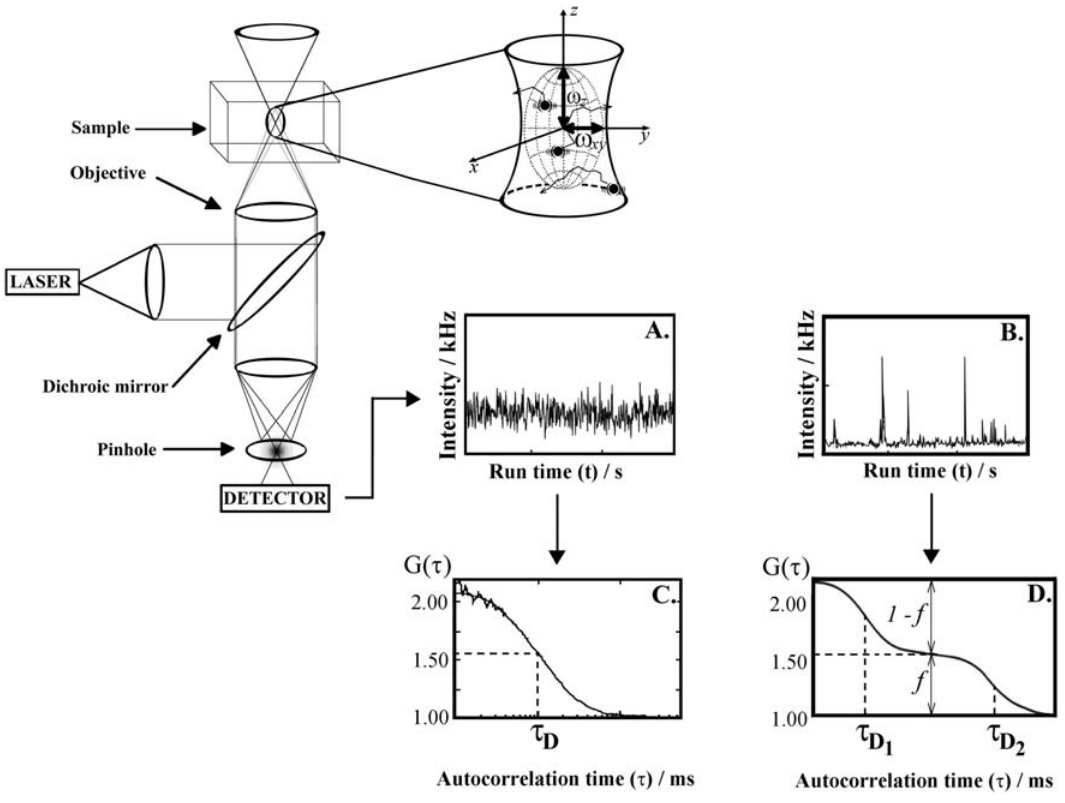
Figure 6. Schematic presentation of the instrumentation for FCS/CLSM. To induce fluorescence, the sample is illuminated by incident laser light. The irradiating laser beam is reflected by a dichroic mirror and sharply focused by the objective to form a diffraction limited volume element. A confocal aperture, set in the image plane to reject the out-of-focus light, further reduces the volume from which fluorescence is detected. This is crucial for providing an elliptical observation volume element and enabling submicrometer resolution and quantitative analysis. Following the absorption of energy, fluorescent molecules lose energy through photon emission. Light emitted by fluorescing molecules passing through the confocal volume element (magnified in the insert) is separated from the exciting radiation and the scattered light by a dichroic mirror and barrier filter, and transmitted to the detector. The number of pulses originating from the detected photons, recorded during a specific time interval, corresponds to the measured light intensity. Examples of fluorescence intensity fluctuations recorded in systems with one component undergoing A. free three-dimensional diffusion or B. free three-dimensional diffusion with binding to a surface. Corresponding autocorrelation curves are shown in C and D, respectively. C. Autocorrelation curve G( t ) fitted using equation (2a). The average number of molecules in the observation volume element is determined from the amplitude of the autocorrelation function (1/ N =0.94), and average residence time t D from the inflection point. D. Autocorrelation curve G( t ) fitted using equation (2c). The complex shape of the autocorrelation curve indicates that two components with different diffusion times, t D1 and t D2 , are present. The average number of particles in the observation volume element is determined from the amplitude of the autocorrelation curve (1/ N =0.8). The ratio of the free fraction versus the bound is given by the ratio of the relative amplitudes (1 2 f )/ f .